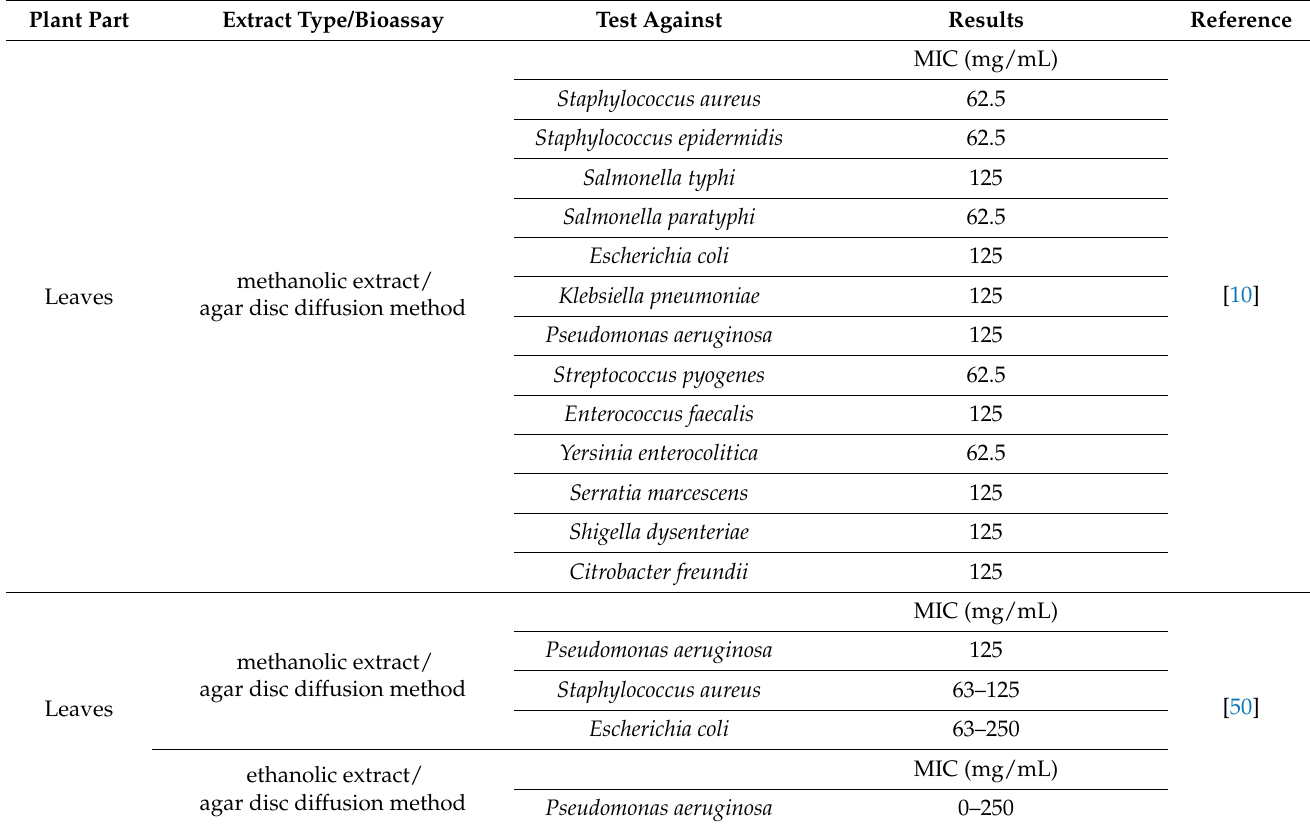
Table 13. Antimicrobial effects of Mespilus germanica L.